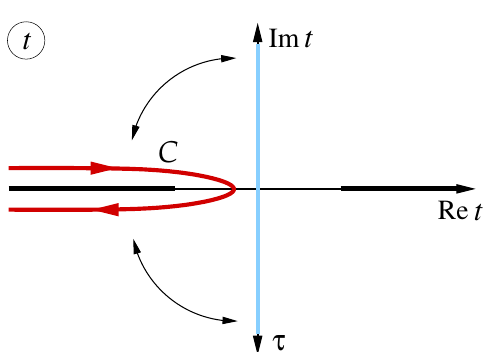
Figure 6. Structure of Minkowski bounce in the complex time plane. The standard Euclidean bounce is defined on the imaginary time axis (blue). Its analytic continuation to the contour C (red) satisfies Feynman boundary conditions at Re t → −∞ . Thick black lines show the branch